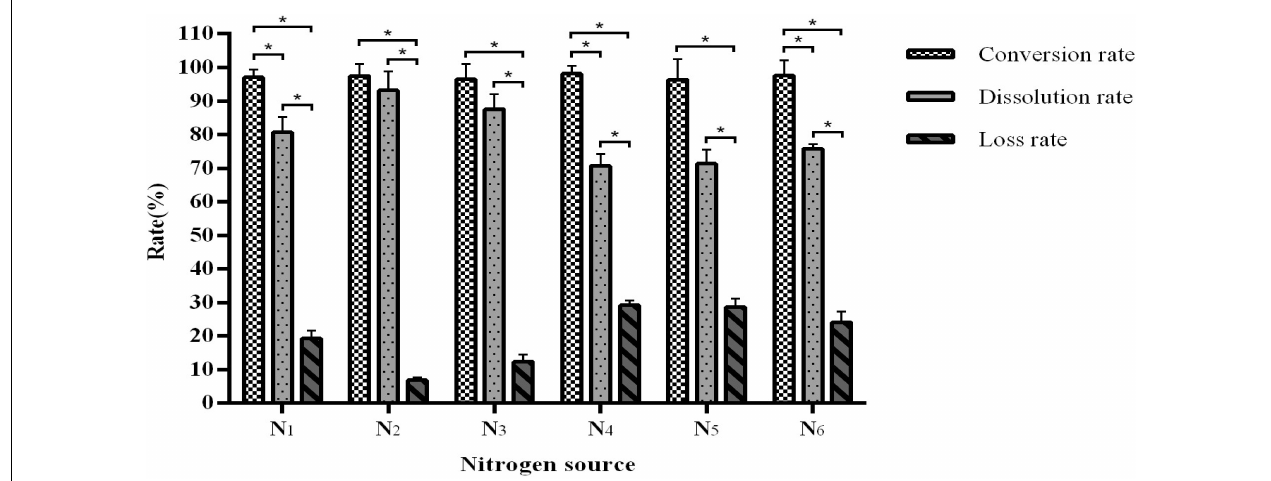
FIGURE 3 | The influence of the nitrogen source on fermentation efficiency. *Indicates significance at the 0.01 level.